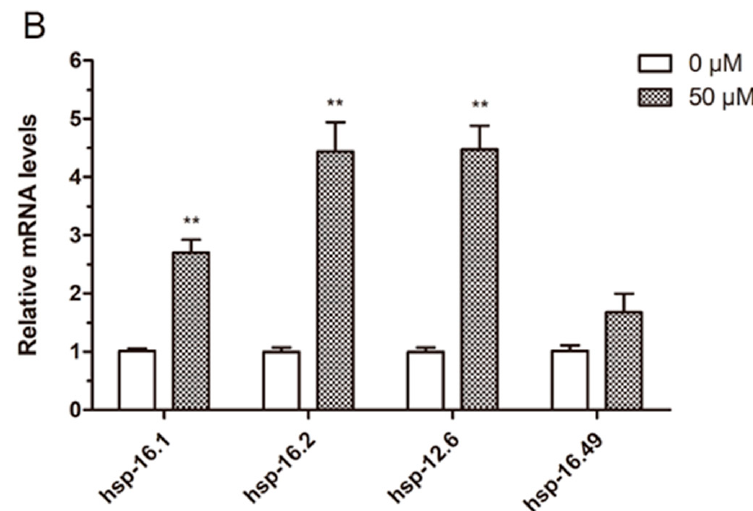
Figure 2. The effects of ellagic acid on the expression of genes related to the stress response in worms exposed to UV radiation. ( A ) The expression of the daf-16 , sod-3 , and hsf-1 genes was measured using qPCR, n > 500. ( B ) The expression of small heat shock protein genes ( hsp-16.1 , hsp-16.2 , hsp-16.49 , and hsp-12.6 ) was determined with qPCR, n > 500. The data are shown as the mean ± SD. p < 0.01 (**).